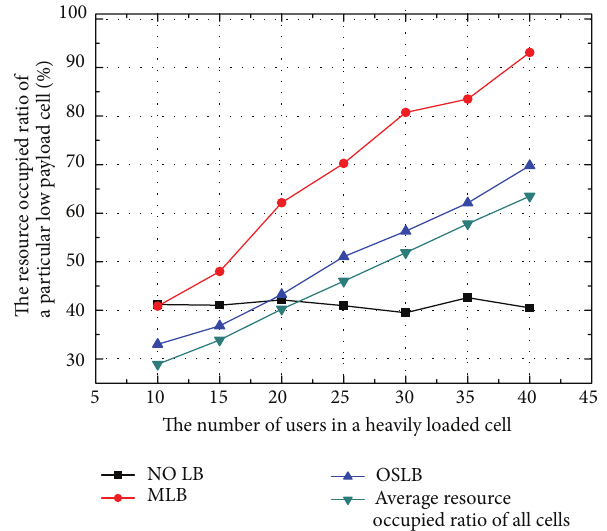
Figure 12: The resource occupied ratio of a particular low payload cell versus the number of users in a heavily loaded